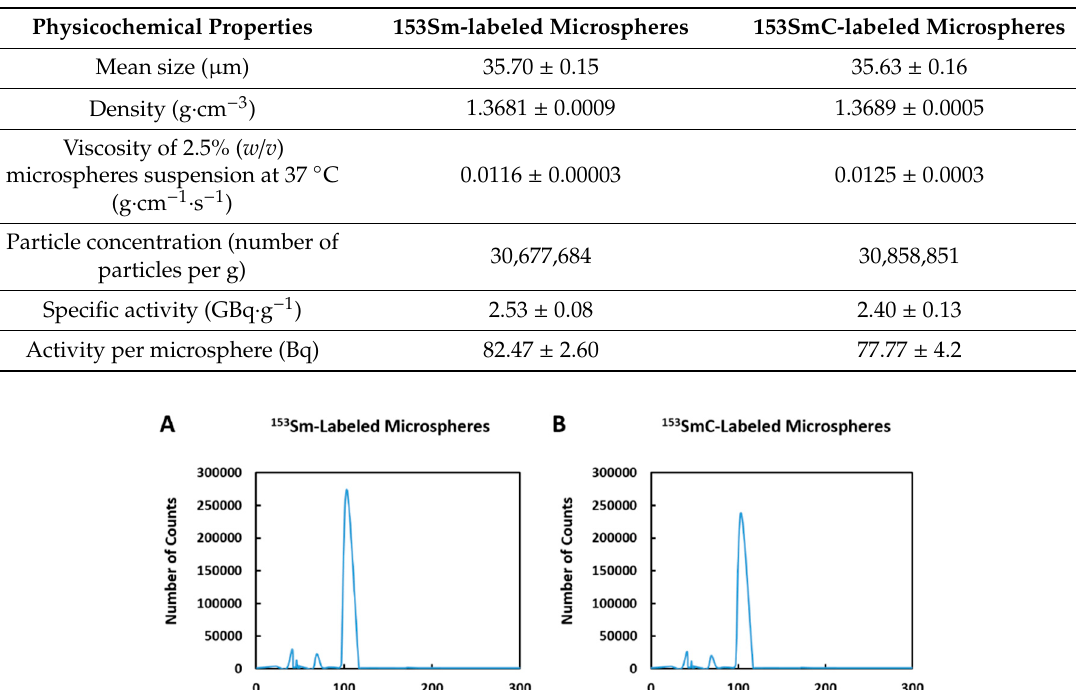
Table 3. Physicochemical characteristics of the 153 Sm- and 153 SmC-labeled microspheres.